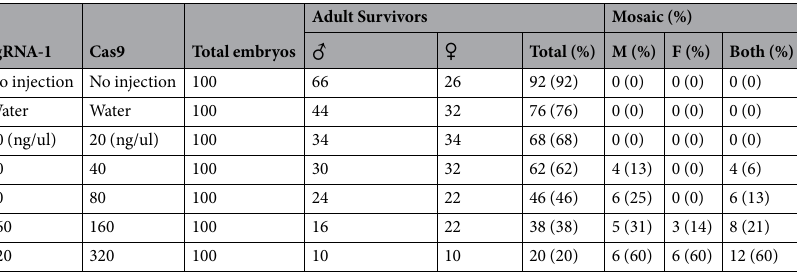
Table 1. Effect of sgRNA and Cas9 protein concentration on N . vitripennis survival and